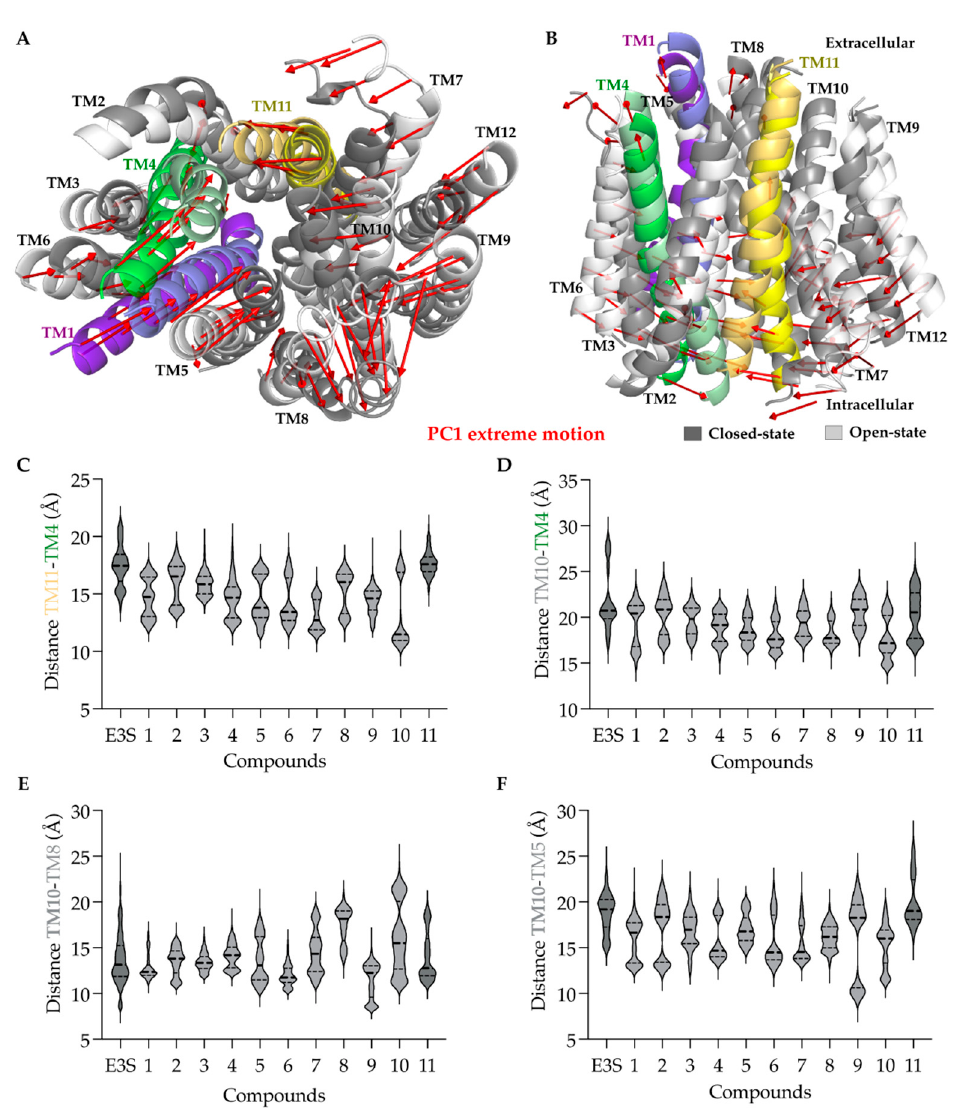
Figure 9. Principal Component Analysis (PCA) of OATP1A2-ligand bound complexes: Principal components analysis revealed two states: open (light gray) and closed (dark gray) from PC1. ( A ) Intracellular view of transmembrane helices displayed closed and open states, and the red arrows show the direction of movement of helices. ( B ) Lateral view of transmembrane helices showing the two states. (C),(D),(E),(F) Centroid distance between two helices measured along the simulations of each protein-ligand complex. ( C ) TM11 residues 544–555 to TM4 residues 173–185. ( D ) TM10 residues 528–538 to TM4 residues 173–185. ( E ) TM10 residues 528–538 to TM8 residues 373–383. ( F ) TM10 residues 528–538 to TM5 residues 192–201.